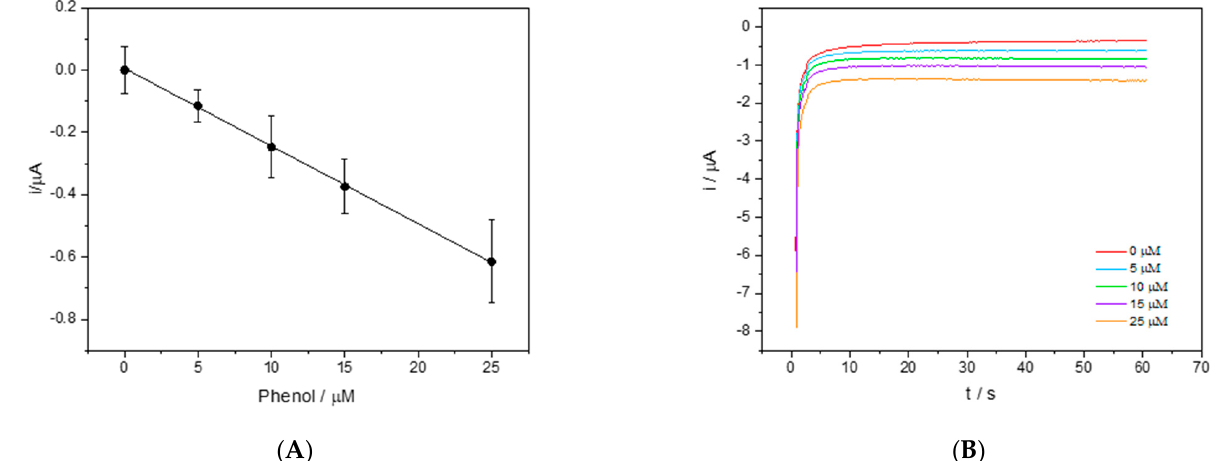
Figure 3. ( A ) The calibration line of phenol in 50% v / v DES-PBS solutions. The chronoamperometric measurement was obtained by applying to the working electrode a potential of − 150 mV vs. the Ag pseudo reference for 60 s. ( B ) The chronoamperometric curves at different concentrations of phenol (0, 5, 10, 15, and 25 μ M).